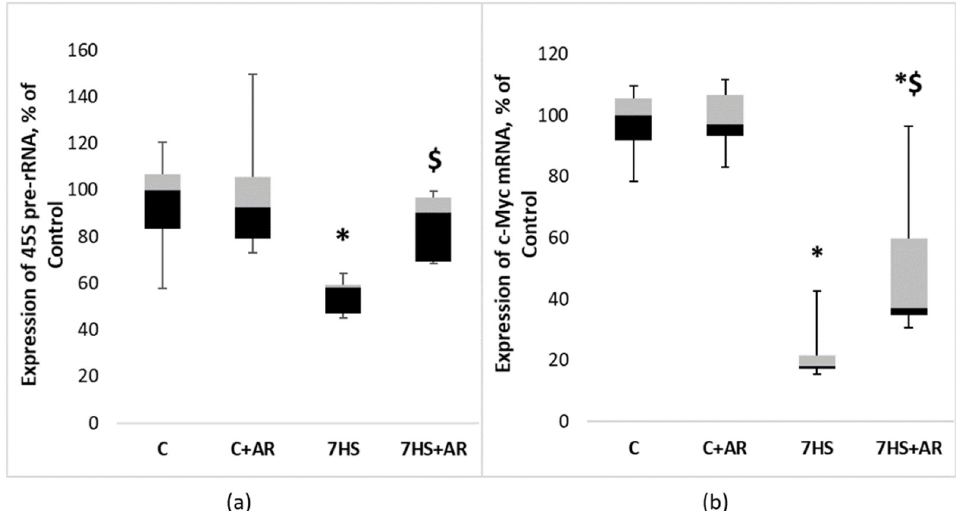
Figure 5. Effect of GSK-3 inhibition during 7-day unloading on the expression of 45S pre-rRNA ( a ) and c-Myc ( b ) in rat soleus muscle. Data are presented as median, interquartile range, minimum and maximum values, expressed as % of control. C, vivarium control group, C + AR, vivarium control rats + daily injections of GSK-3 inhibitor (AR-A014418) for 7 days, 7HS, hindlimb suspension for 7 days, 7HS + AR, 7-day hindlimb suspension + daily injections of GSK-3 inhibitor (AR-A014418), *: p < 0.05 vs. C, $: p < 0.05 vs. 7HS.